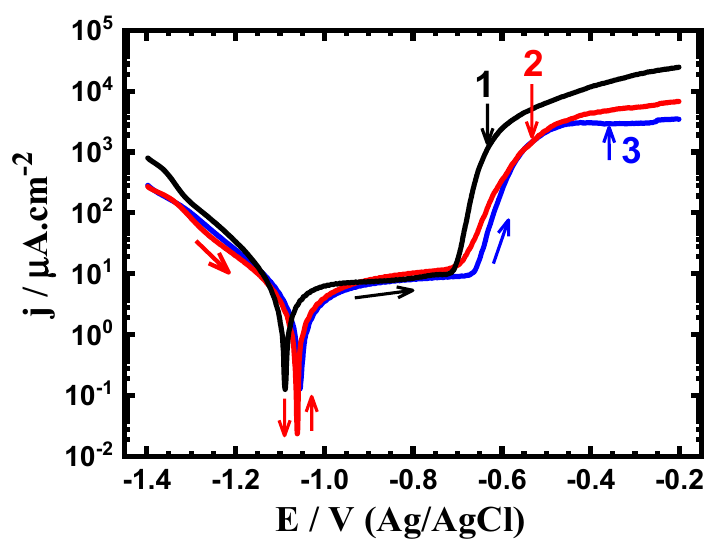
Figure 5. Polarization curves of (1) first Al-SiC nanocomposite, (2) second Al-SiC nanocomposite and (3) third Al-SiC nanocomposite after 48 h exposure in 3.5% NaCl. Here, k is a constant (to define the unit for R Corr , k = 3272 mm (amp − 1 cm − 1 year − 1 )), E W is the equivalent weight (E W = 9 g equivalent), d is the density (d = 2.7 gm cm − 3 ), and A is the area of the surface (A = 1 cm 2